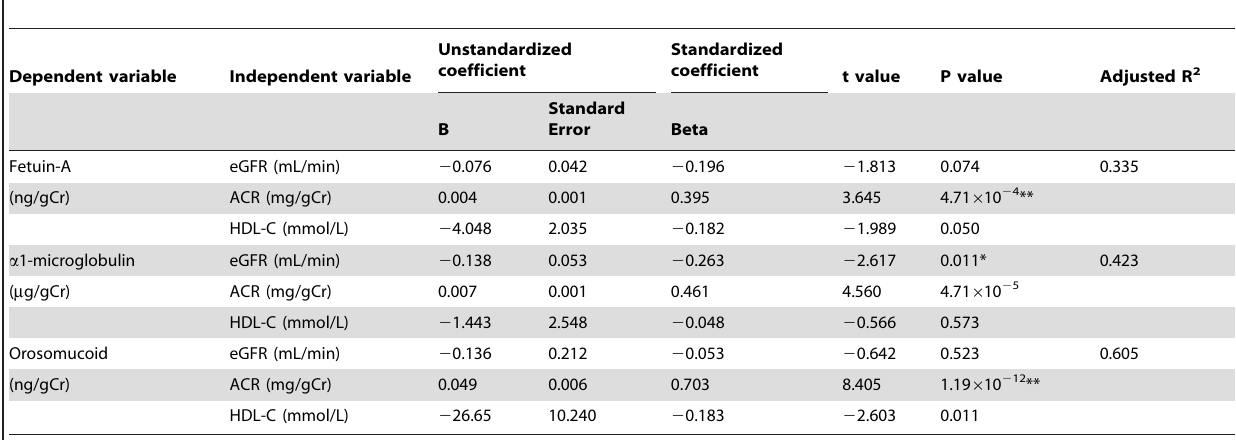
Table 7. Multiple linear regression analysis using urinary sialylated glycoprotein excretions as dependent variables in the patients with type 2 diabetes (n=85).